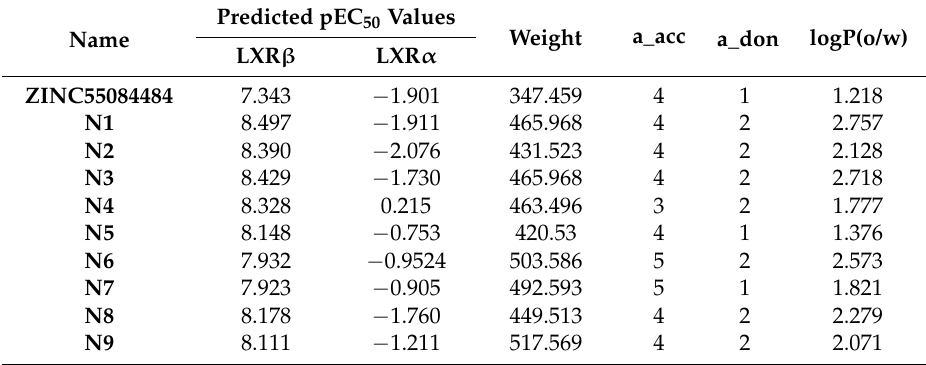
Table 7. Drug-like property descriptors of new designed LXR β -selective agonists.